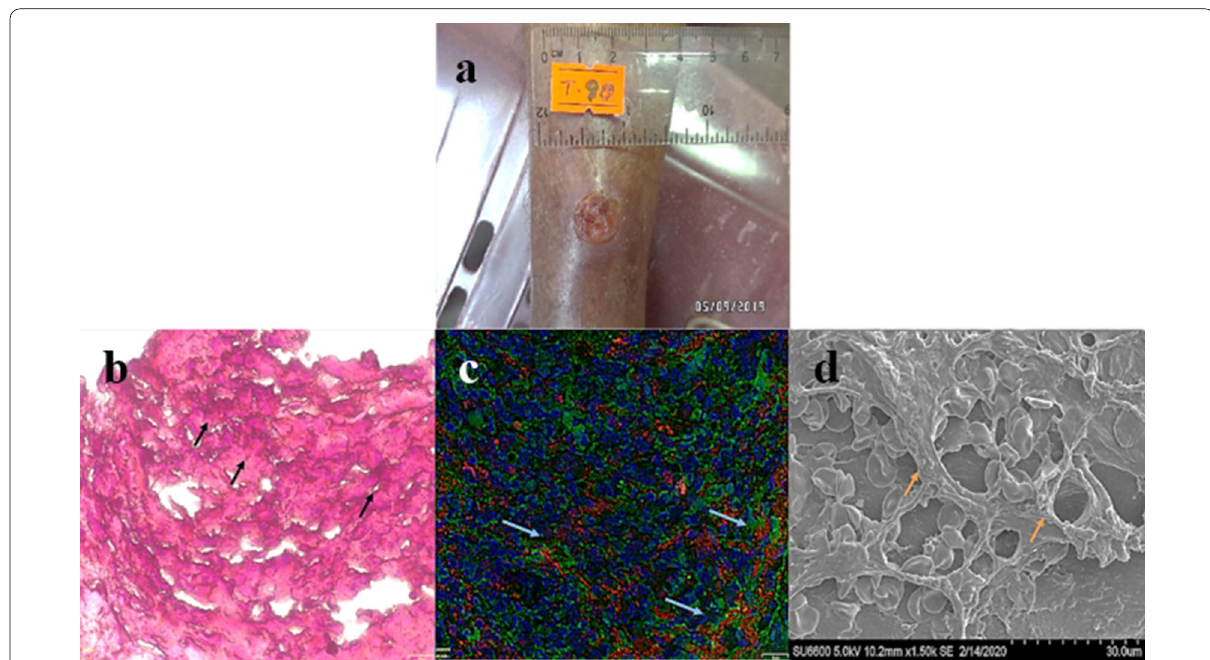
Fig. 1 Visualization of bacterial biofilms in cutaneous leishmaniasis wound. Wet ulcer ( a ); Gram staining, the extra-polymeric substances (EPS) is stained in pinkish orange with the Safranin dye ( b ); fluorescence in situ hybridization—bacteria in red due to Cyanine 3-tagged Eu-bacterial rRNA probe, EPS in green due to Concanavalin A-conjugated Alexa Fluor 488 and tissue nuclei in blue due to DAPI staining ( c ), scanning electron microscopic image ( d ). Arrows indicate the